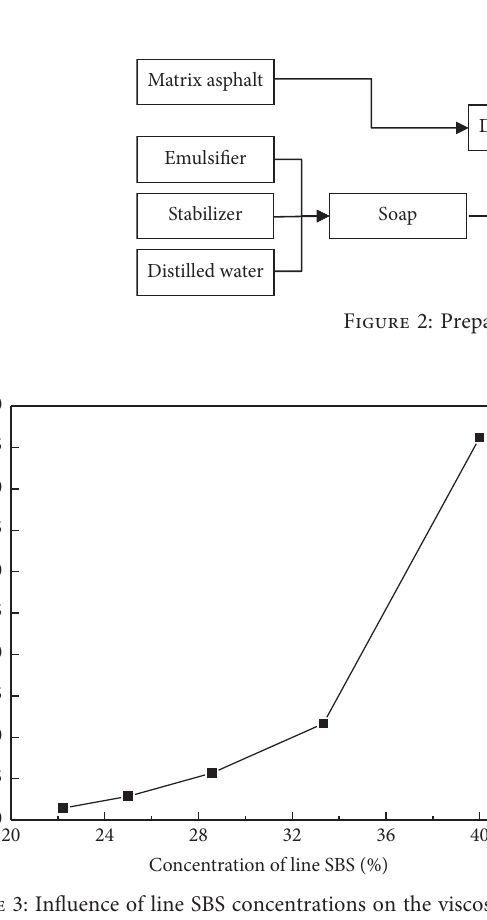
Figure 1: The fabricated SBS latex.